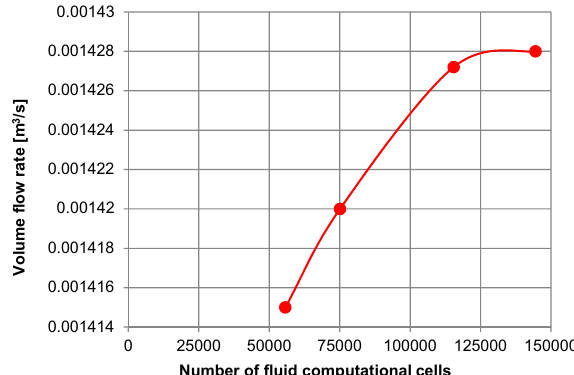
Figure 7. Numerical grid quality results.